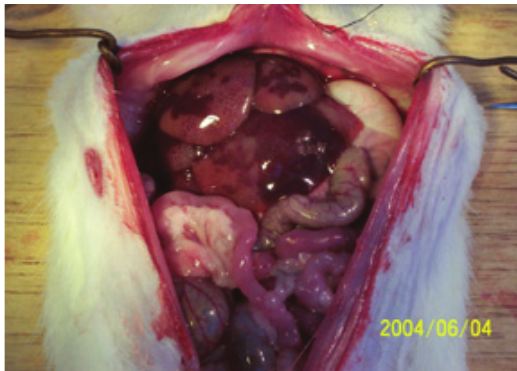
FIGURE 1 - Macroscopic changes in the livers of receipts.